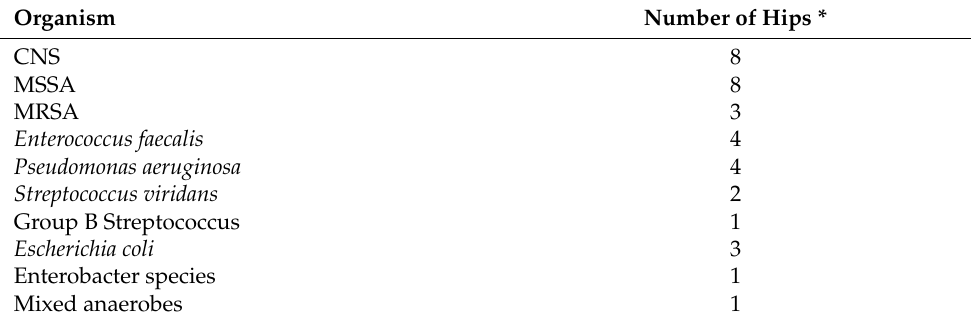
Table 3. Microorganisms causing infection prior to first-stage